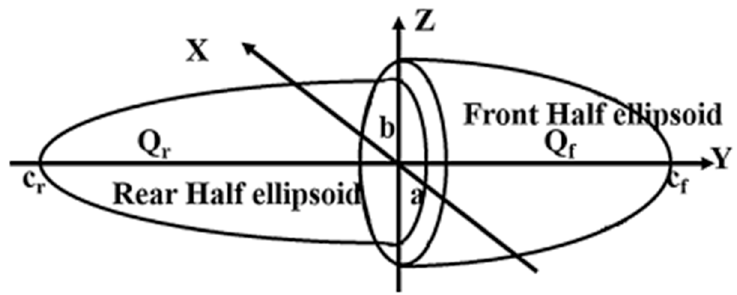
Figure 9. 3D-double ellipsoidal heat source used in the simulation. Table. 4 The finalized parameters of the heat source model in the simulation.